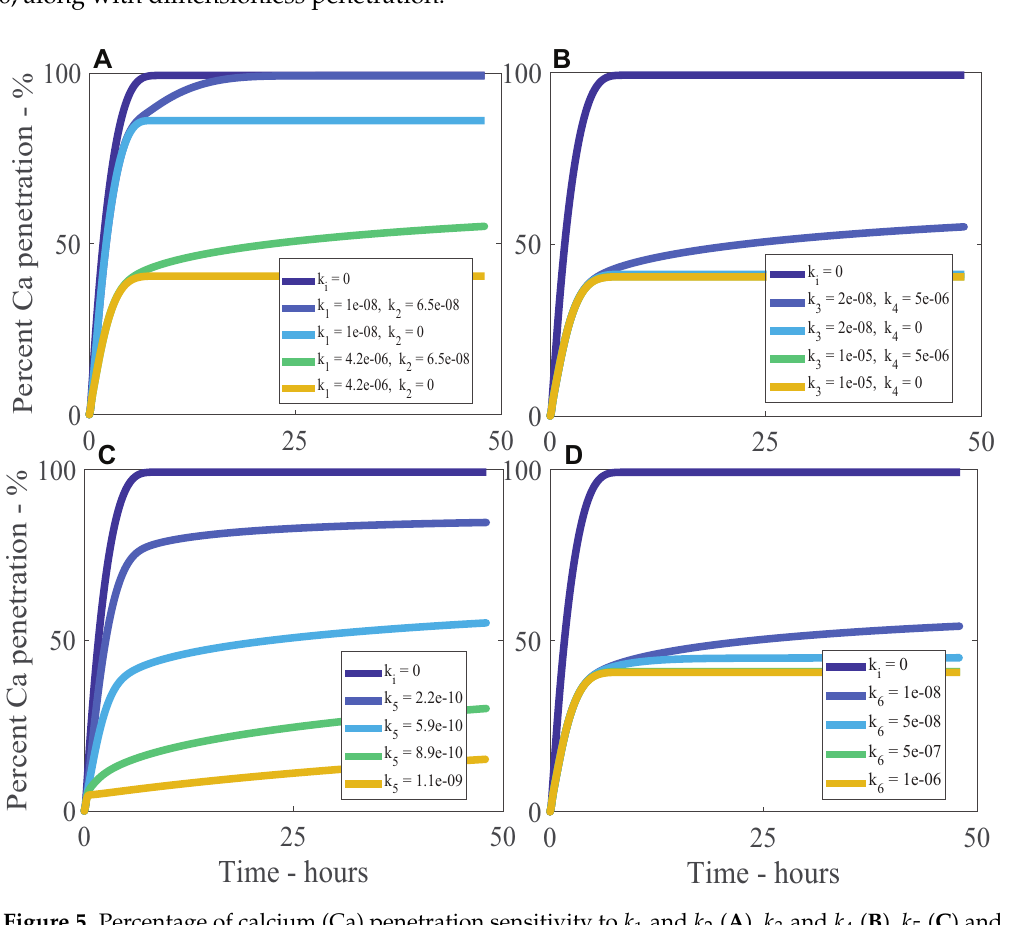
of 5 g/L and RSO 5 of 2